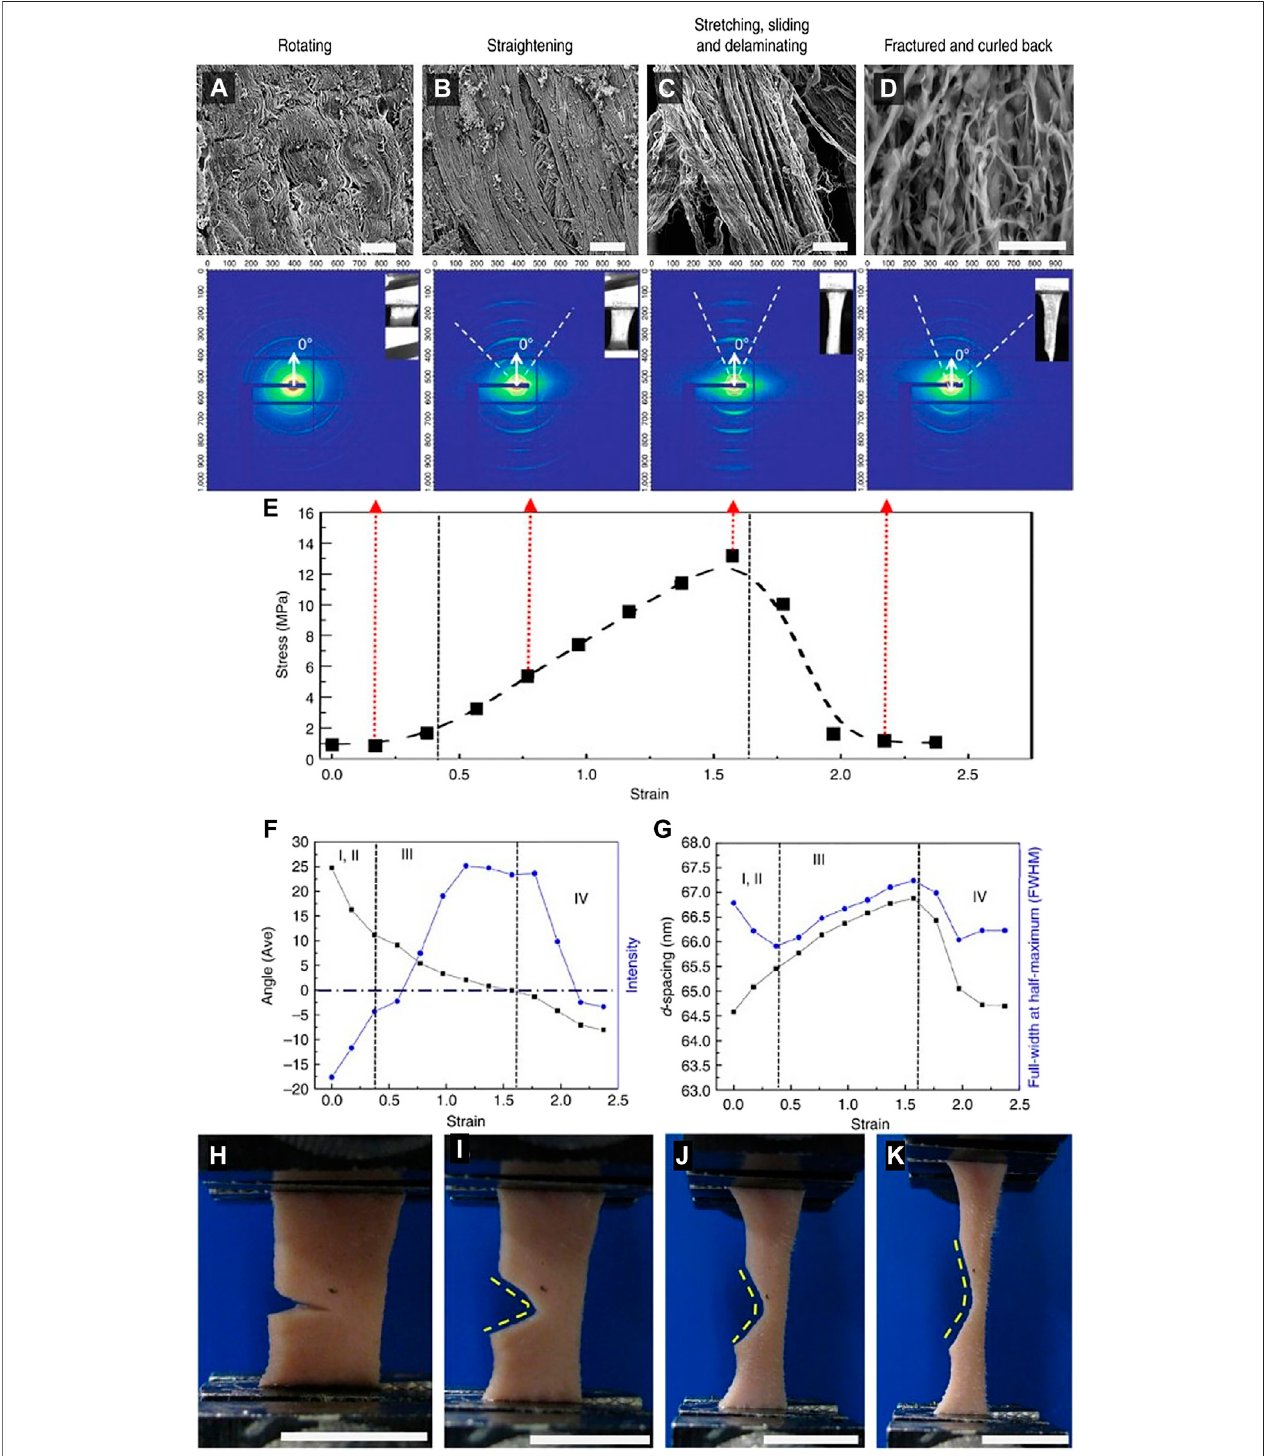
FIGURE 10 | (A – D) Four structural mechanisms under tensile loading of rabbit skin: Rotating, straightening, stretching, sliding, and delaminating, and fracture. (E) Variations in SAXS peak intensity during a tensile test of rabbit skin divided into four stages 1, 2) toe and heel regions, 3) Linear region, and 4) Fracture. (F) Fibril reorientation: Angle of normal to the tensile axis (black dots) versus intensity of fi brils (blue dots) as a function of strain. (G) Fibril stretching and sliding: D-spacing (black dots) and full-width-at-half-maximum (FWHM) (blue dots) of fi brils as a function of strain. (H – K) Tear resistance of notched rabbit skin under uniaxial tension. Adapted from Yang et al. (2015) under CC BY